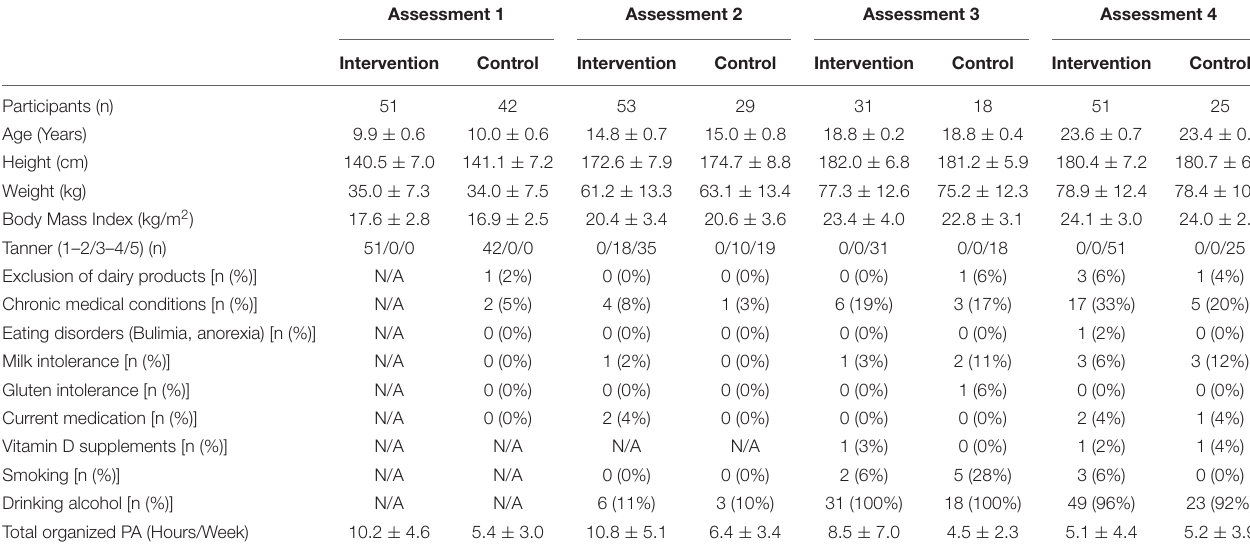
TABLE 1 | Anthropometry, pubertal development (Tanner stage), and lifestyle characteristics in the boys.